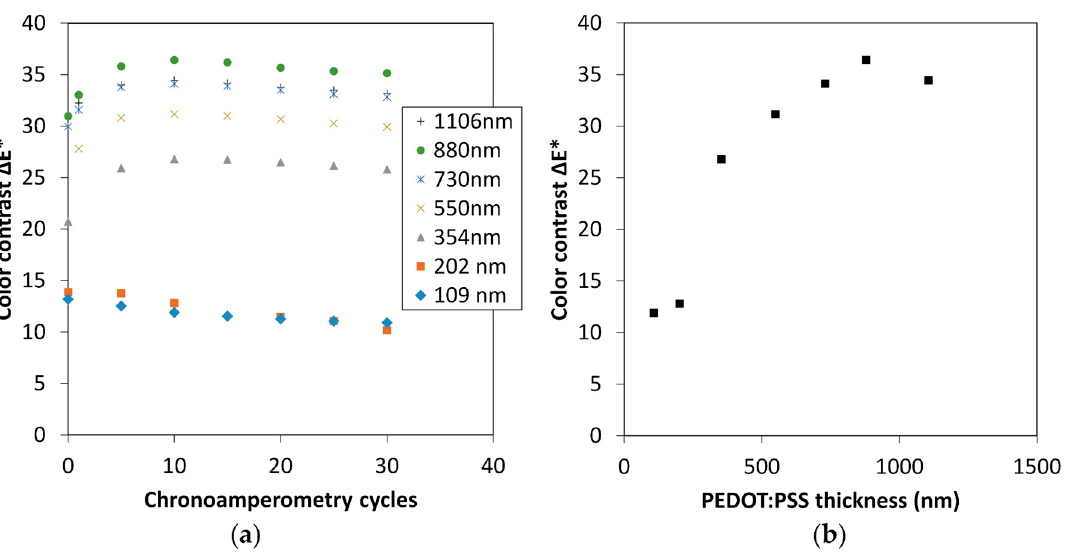
Figure 4. ( a ) Chronoamperograms in a three-electrode cell con fi guration at − 1.3 V for 20 s and +1.3 V for 20 s of the PEDOT:PSS layer at the optimized thickness of 880 nm, ( b ) corresponding optical transmittance spectra at oxidized and reduced states of PEDOT:PSS layer at the optimized thickness of 880 nm (the pictures of the thin films during the test are presented in the inset).